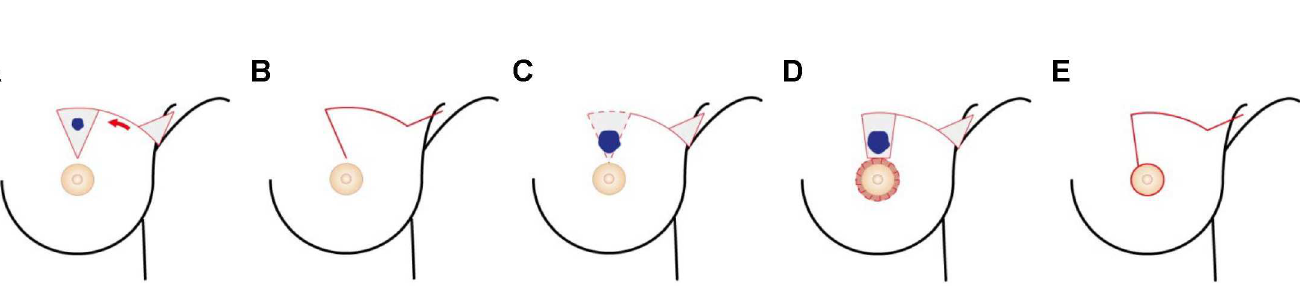
PLOS ONE | DOI:10.1371/journal.pone.0168434 December28,